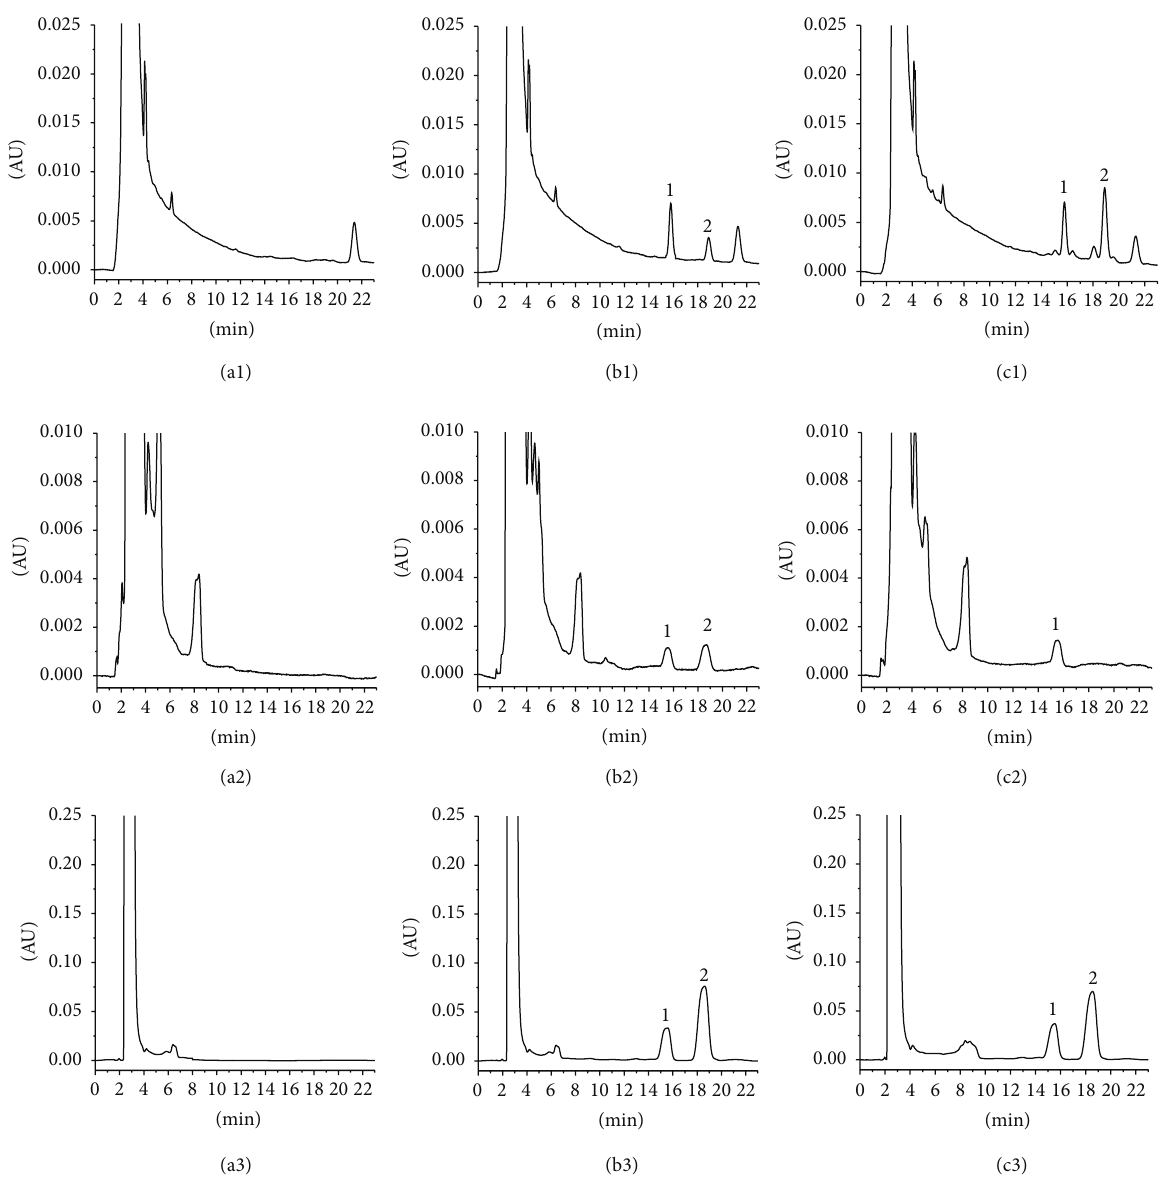
and faecal homogenate were determined by the HPLC-UV method. Figure 3 shows mean plasma concentration-time curves of ergosterol after administration. Pharmacokinetic parameters are listed in Table